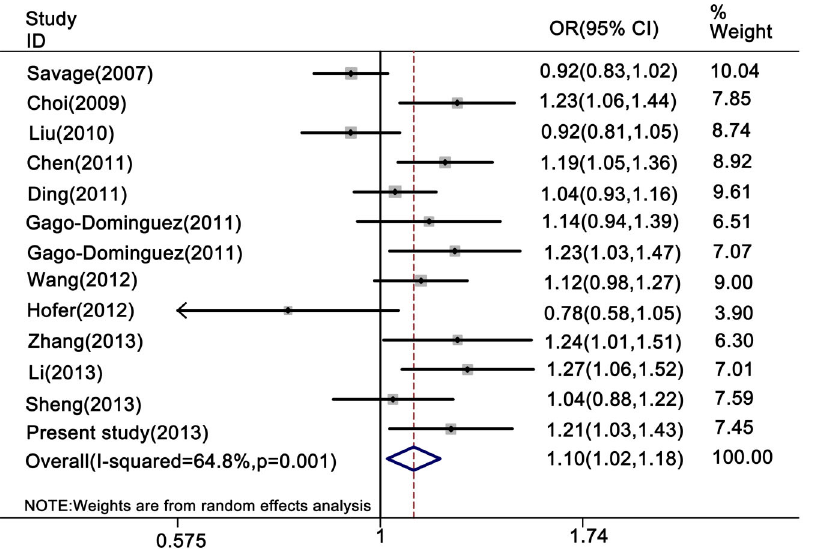
Figure 1. Forest plot of cancer risk associated with the rs2736098 polymorphism (additive model). The squares and horizontal lines correspond to the study-specific OR and 95% CI. The area of the squares reflects the study-specific weight (inverse of the variance). The diamonds represent the summary OR and 95% CI. The rs2736098 polymorphism was weakly associated with an increased risk of cancer in the additive model.